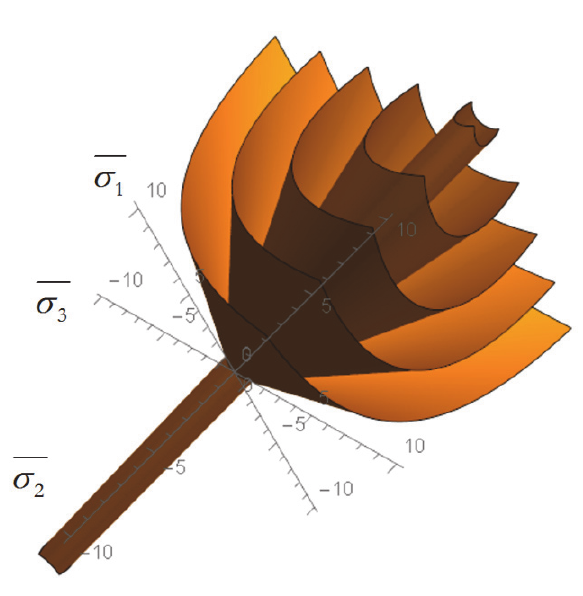
Figure 1: Failure surface according to a Drucker-Prager model assuming  changing from 0 until to 1 with a step of